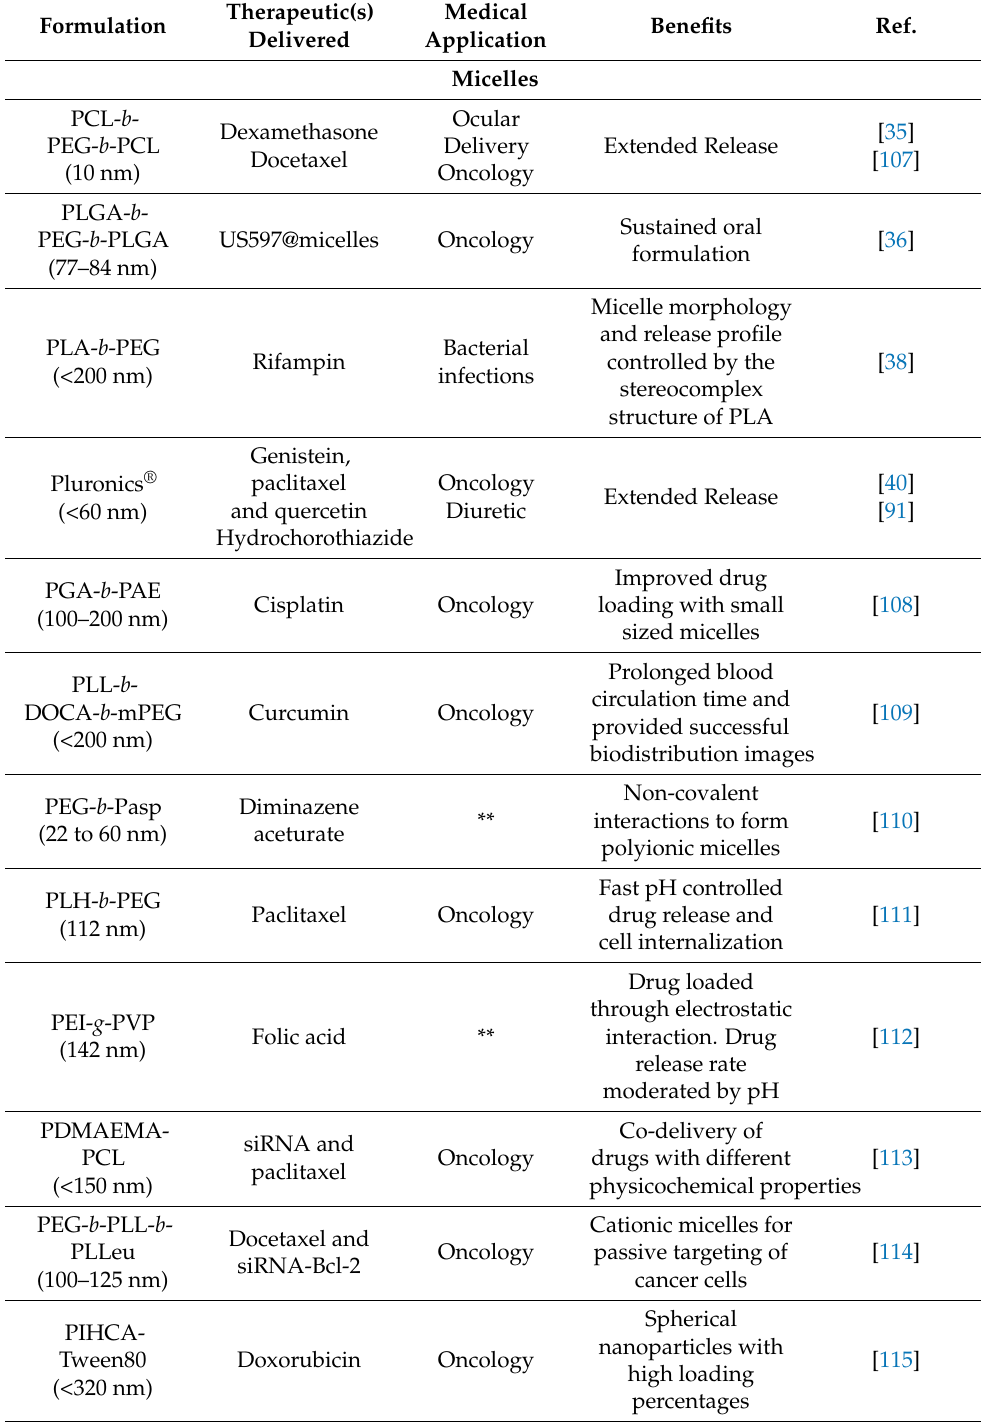
Table 2. List of FDA approved biopolymers used in the formation of self-assembled structures for controlled